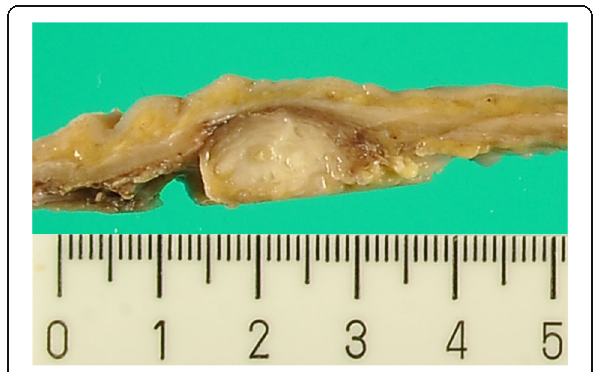
Fig. 3 Macroscopic findings of the resected specimen. Macroscopically, the nodule suspected as lymph node metastasis was relatively well defined but did not have a clear capsule